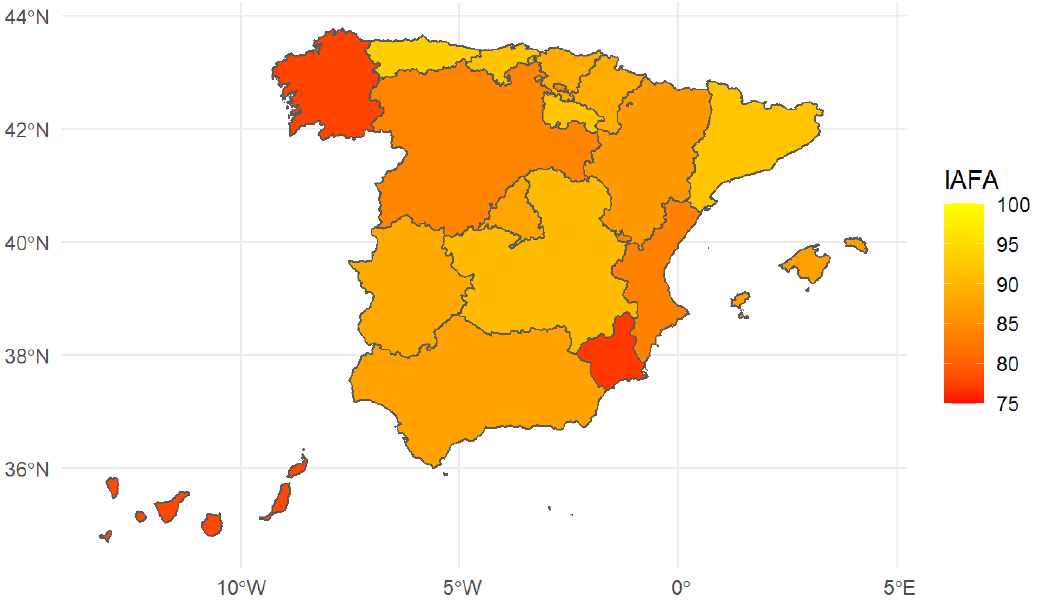
Figure 4. Regional Index of Autonomy in Food Acquisition in Spain, 2020. Source: compiled by the authors based on data from EHSS, 2020 ( n = 6676). Table 5. IAFA, standardized IAFA and 95% confidence interval (in parentheses below) by regions. CCAA